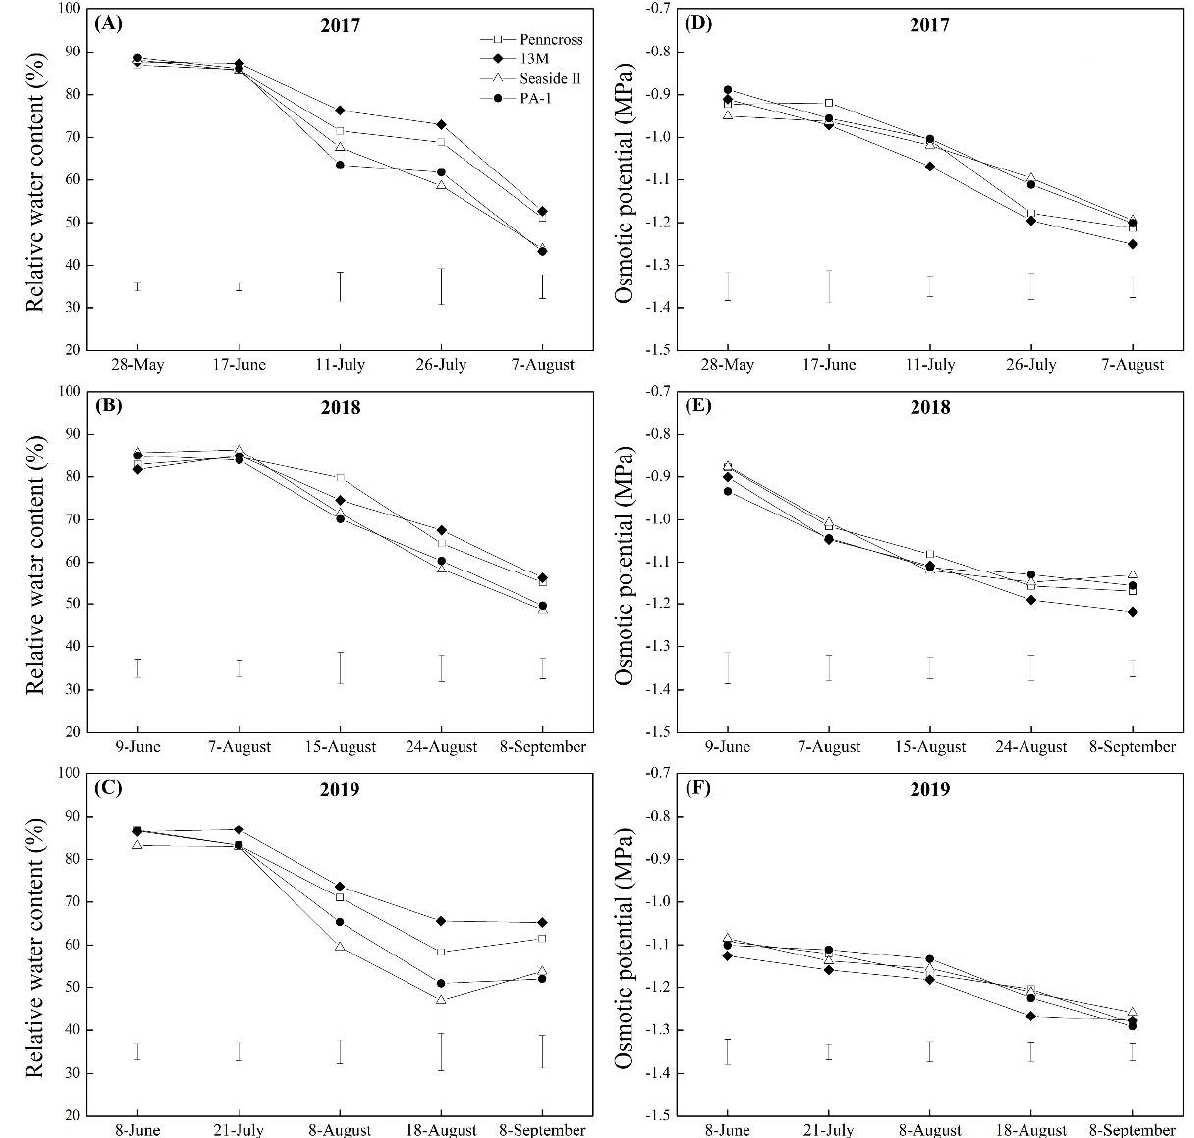
Figure 7. Change in ( A – C ) relative water content (RWC) and ( D – F ) osmotic potential (OP) of four different creeping bentgrass cultivars (Penncross, 13M, Seaside II, and PA-1) during summer in ( A ) 2017, ( B ) 2018, and ( C ) 2019. Vertical bars below curves indicate least significant difference (LSD) values ( p < 0.05) at a given day.